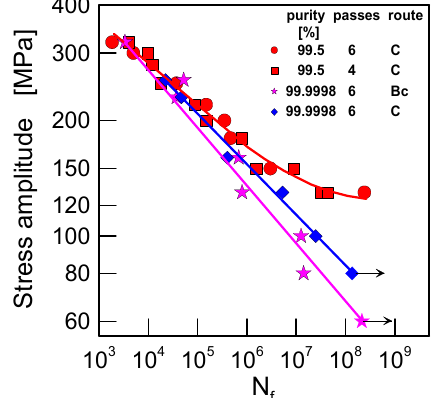
Figure 8: S-N data of UFG Cu of different purity and processed by different routes and number of ECAP passes.